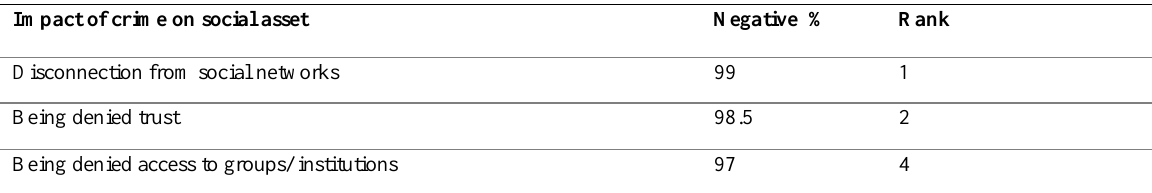
Table 4: Impact of crime on social